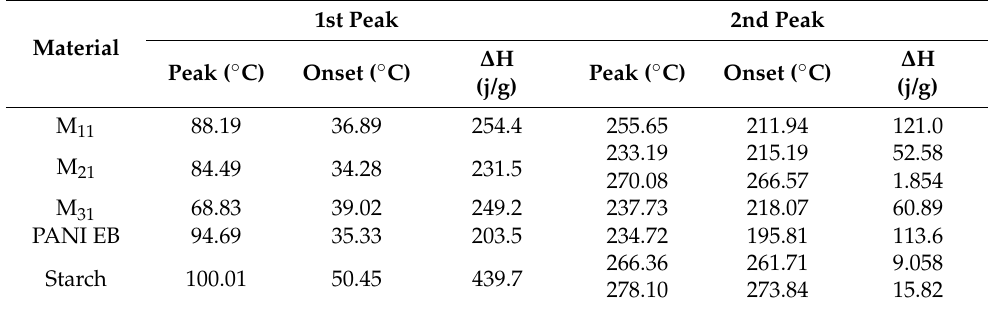
Table 7. Data obtained from DSC thermograms of starch, PANI, and PANI–starch biocomposites.